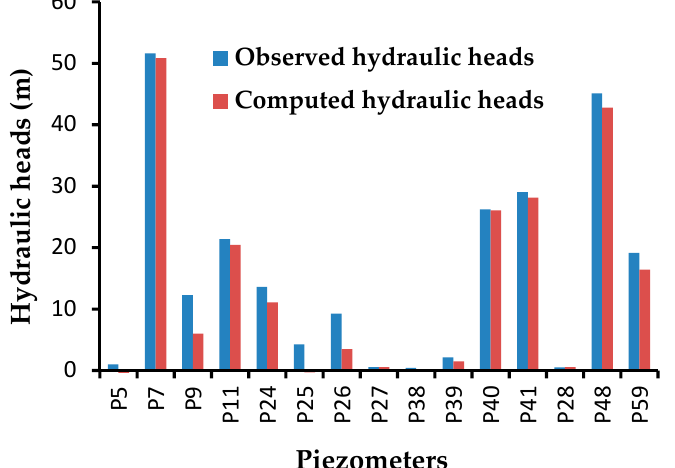
Figure 9. Comparison of observed and computed hydraulic heads in the transient state after the